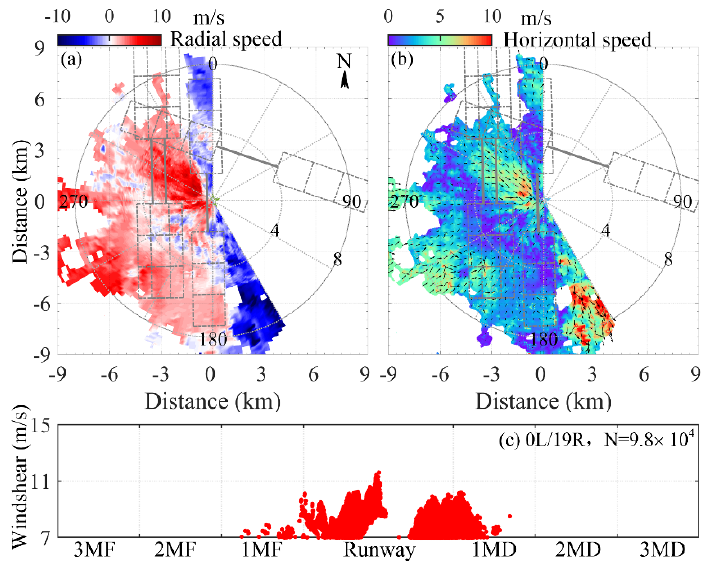
Figure 7. The windshear event detected by the CDWL on May 26, 10:33:38–10:34:21 (UTC). ( a ) Radial speed, ( b ) horizontal speed and wind vector, ( c ) windshear ramps center distribution. N is the number of windshear ramps that exceed 7